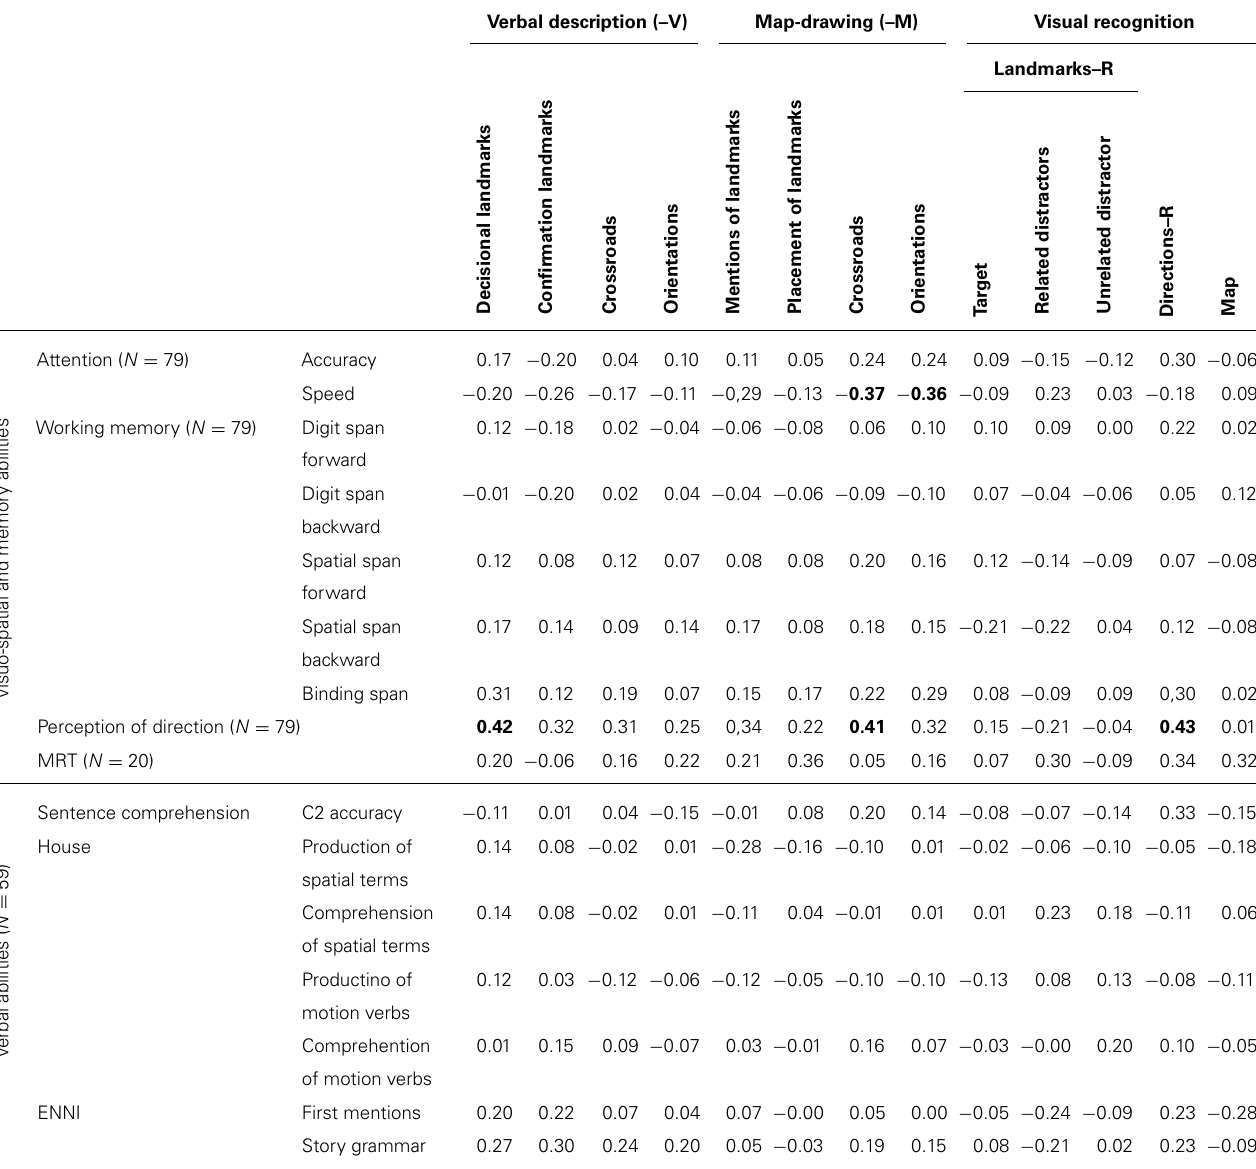
Table 3 | Partial correlations between cognitive abilities vs performance in the route tasks controlled for age (with Bonferroni’s corrections, significant correlations of up to p < 0.05 are indicated in